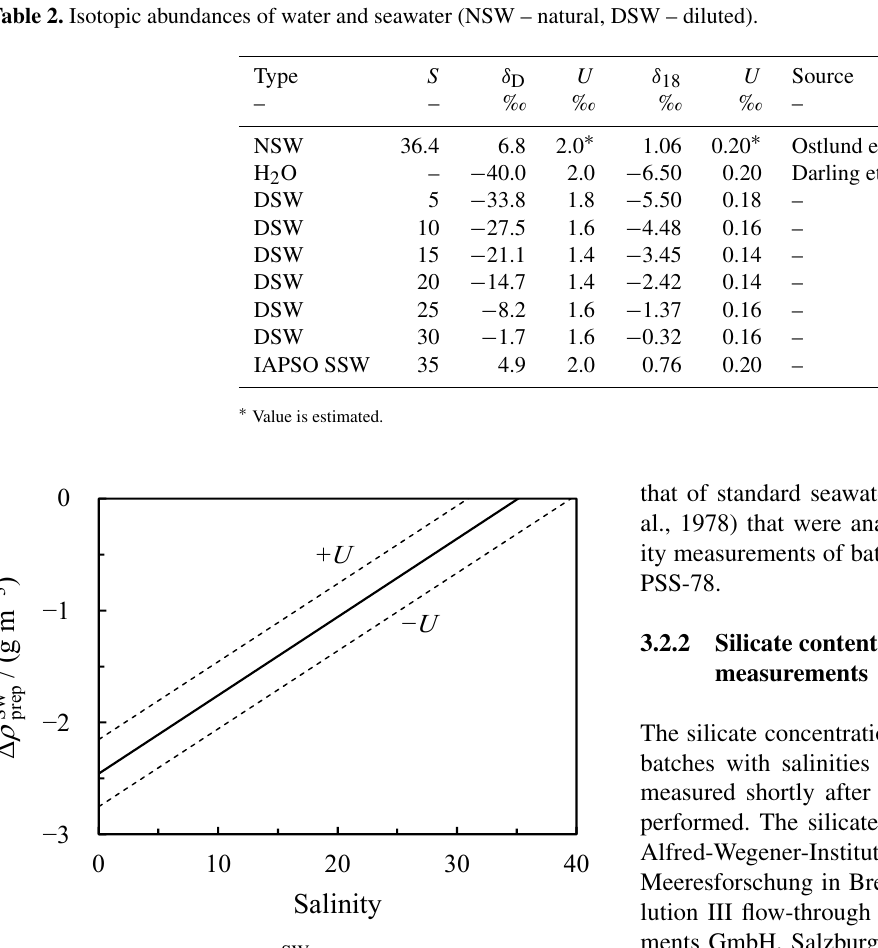
Figure 2. Density difference (cid:49)ρ SW prep caused by isotopic water com- position change (relative to IAPSO SSW) during preparation. U – estimated